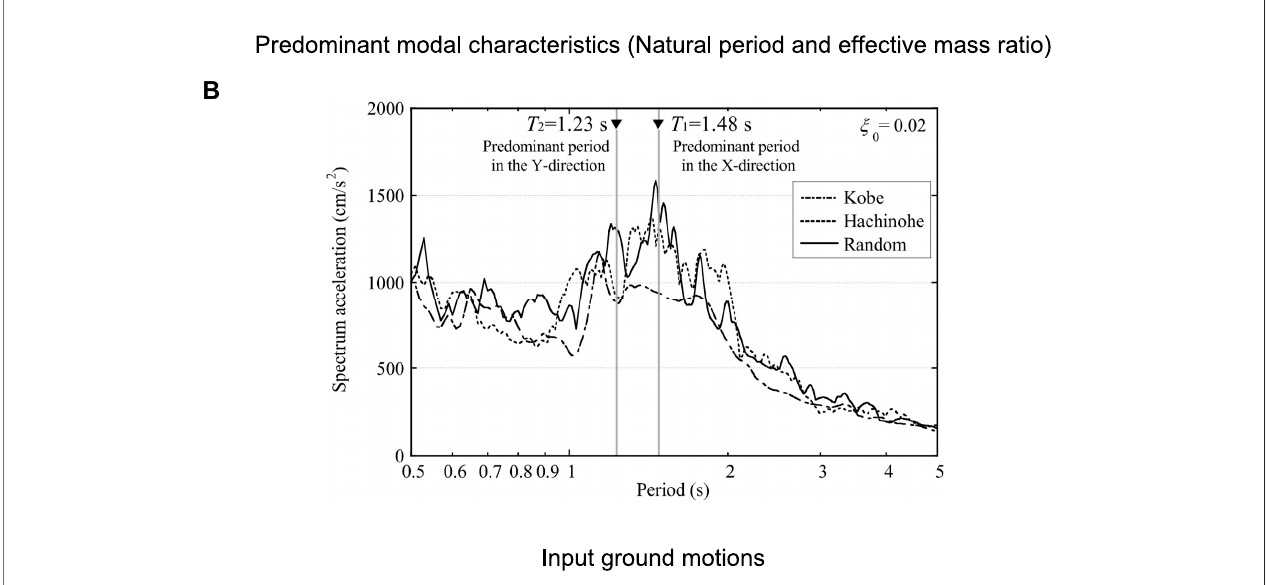
FIGURE 2 | Predominant modal characteristics of the BF model and input ground motions: (A) Predominant modal characteristics (Natural period and effective mass ratio), (B) Input ground motions.